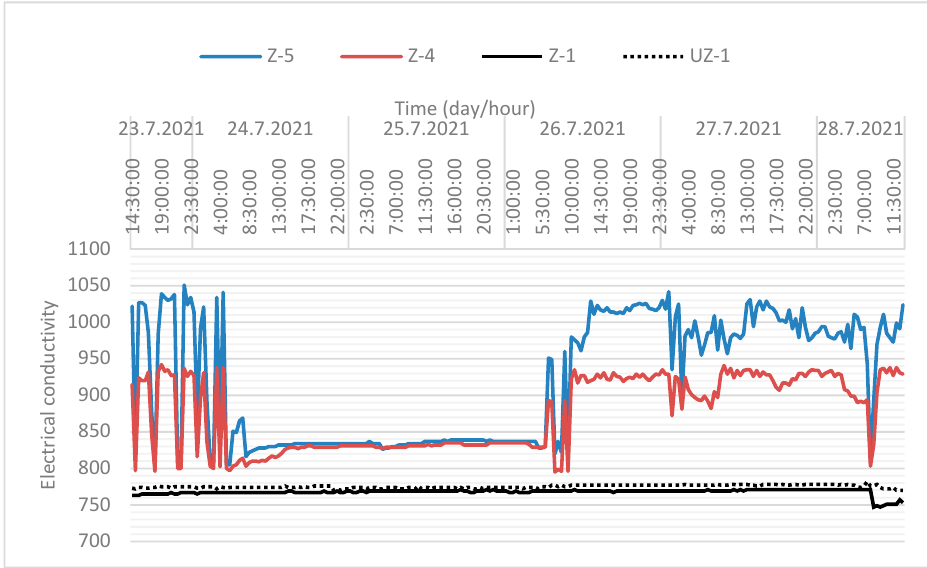
Figure 22. Display of electrical conductivity (µS/cm) in wells during pumping.